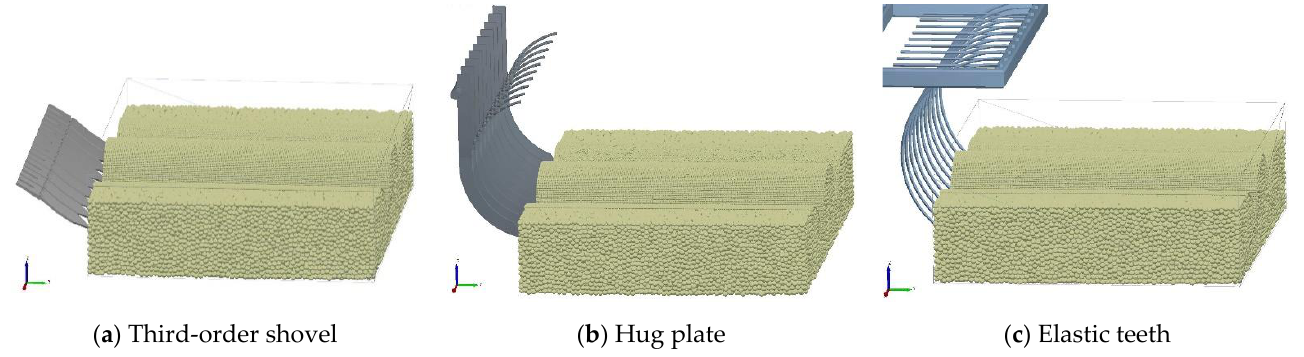
Figure 4. Interaction model of film-lifting parts and whole plastic-film mulching on double ridges.